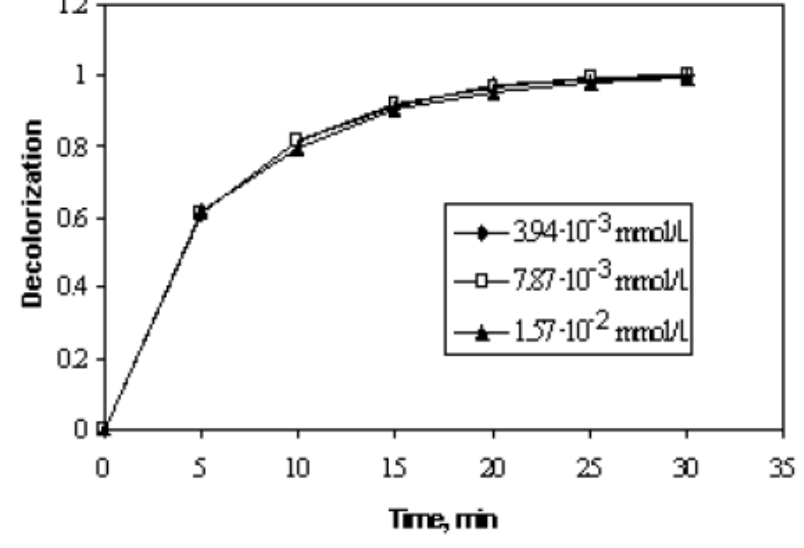
Fig. 12 Effect of Cu 2+ ions on AOP in alkaline medium. Initial conditions: C dye =50 mg/L, [H 2 O 2 ]= 17.318